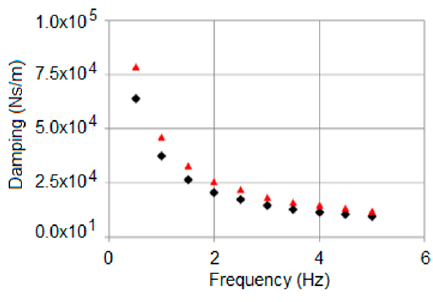
Figure 15. Stiffness vs. frequency. Figure 15. Sti ff ness vs. frequency.